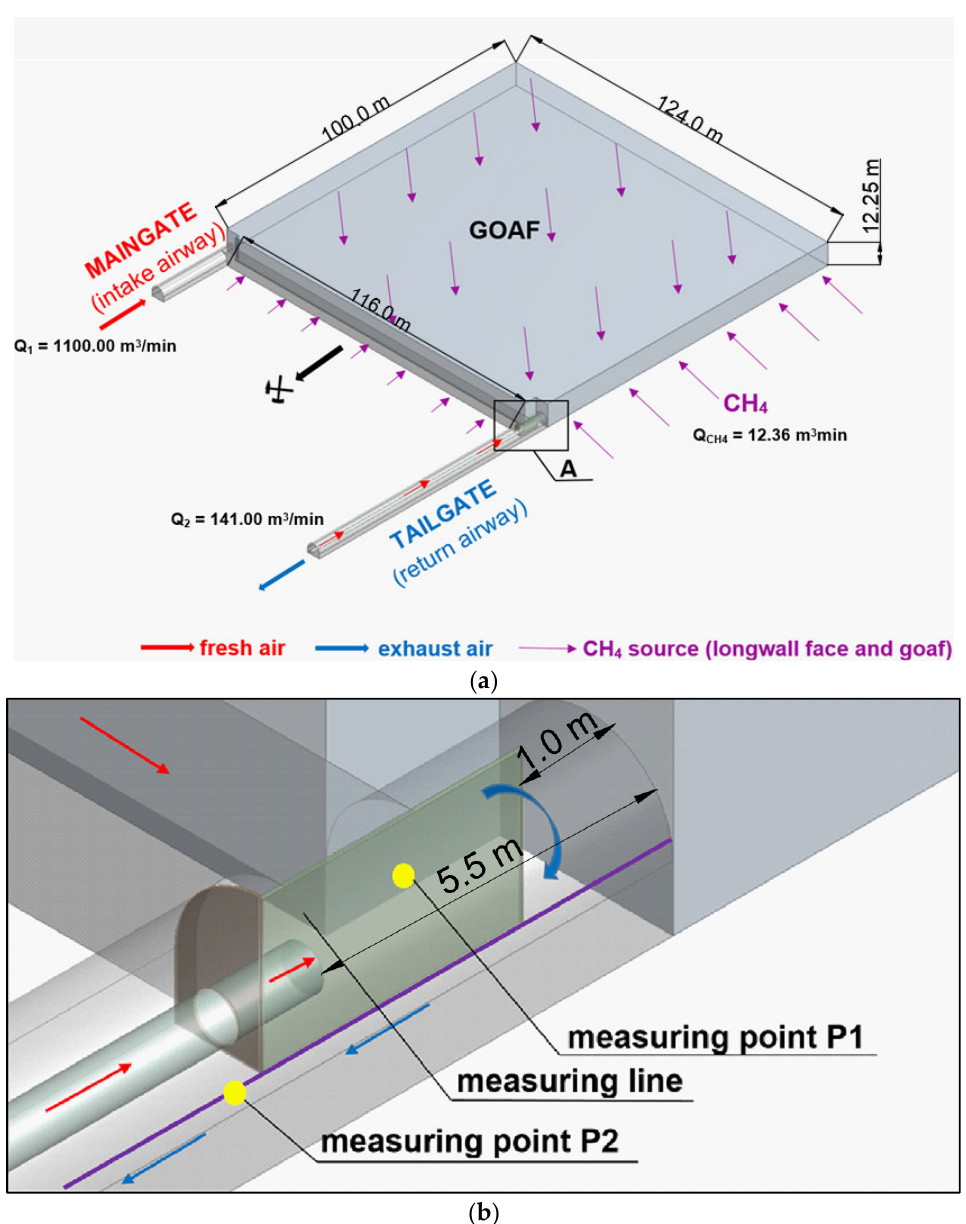
Figure 6. Geometry of the computational domain (longwall, longwall galleries, goaf and air duct, ventilation curtain, and ventilation sluice).